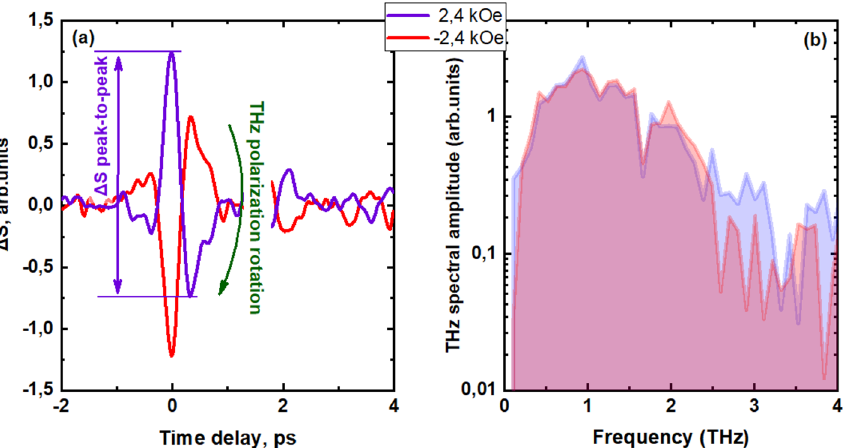
Figure 1. ( a ) Time-domain profile of the THz signal generated in the “hard axis” geometry. Green arrow shows the change in the THz polarization angle by 180 degrees. Red arrow shows the peak-to-peak amplitude; ( b ) correspondent emission